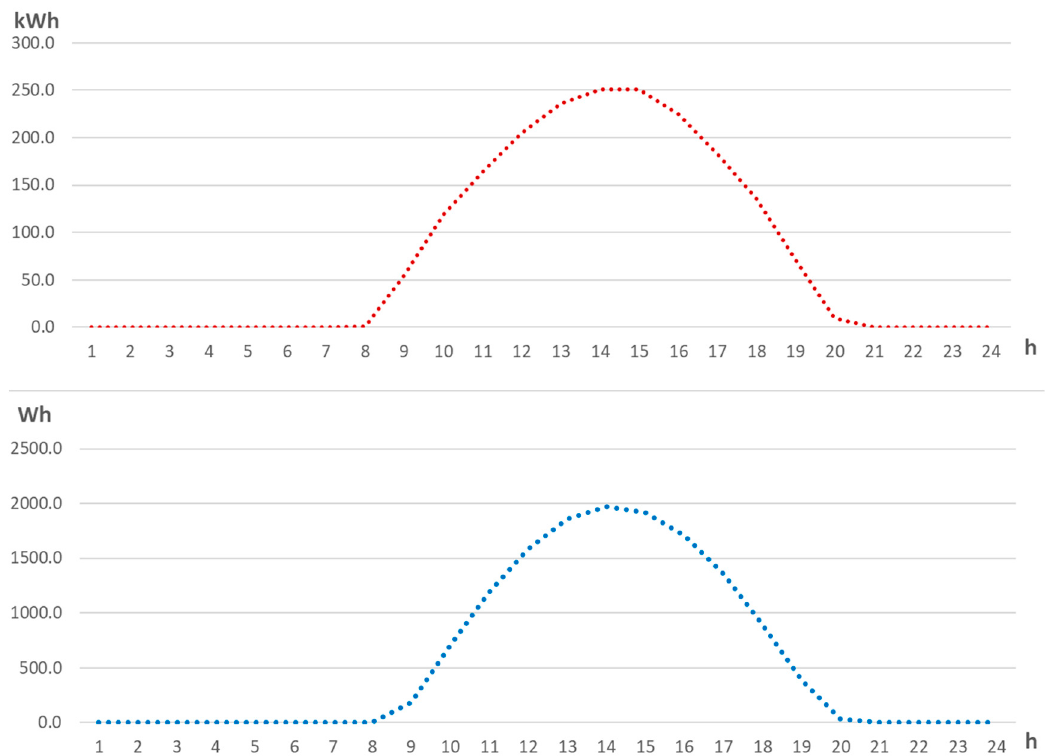
Figure 7. Maximum aggregated hourly energy produced by an energy community ( above ) and a single prosumer ( below ) for a sunny simulation day. Source: self-elaboration.